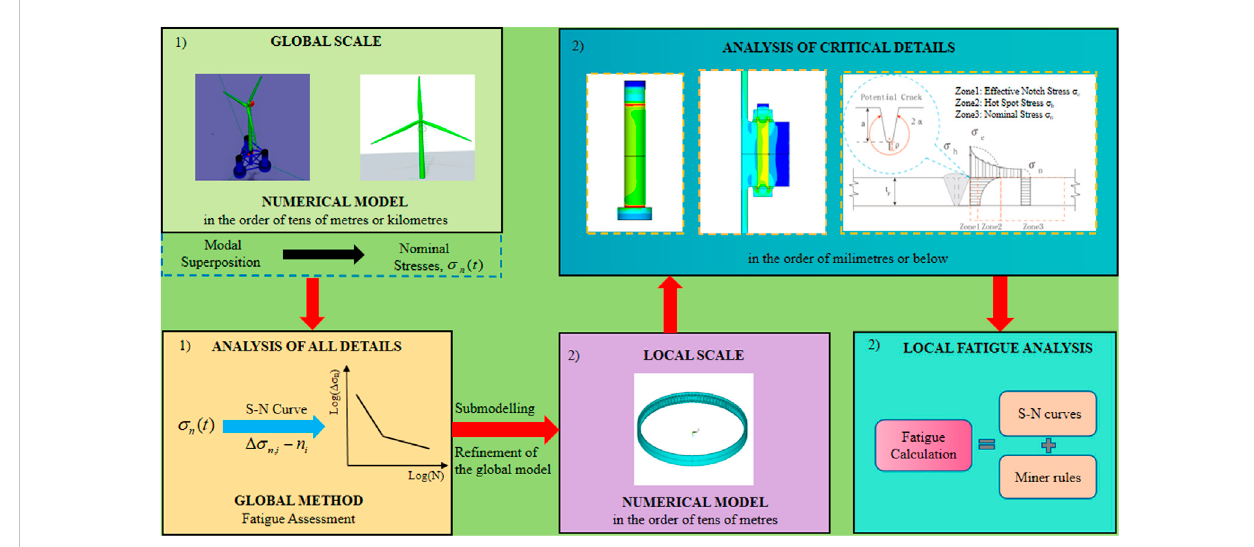
FIGURE 14 Work fl ow of the global – local fatigue assessment methodology for offshore wind turbines.